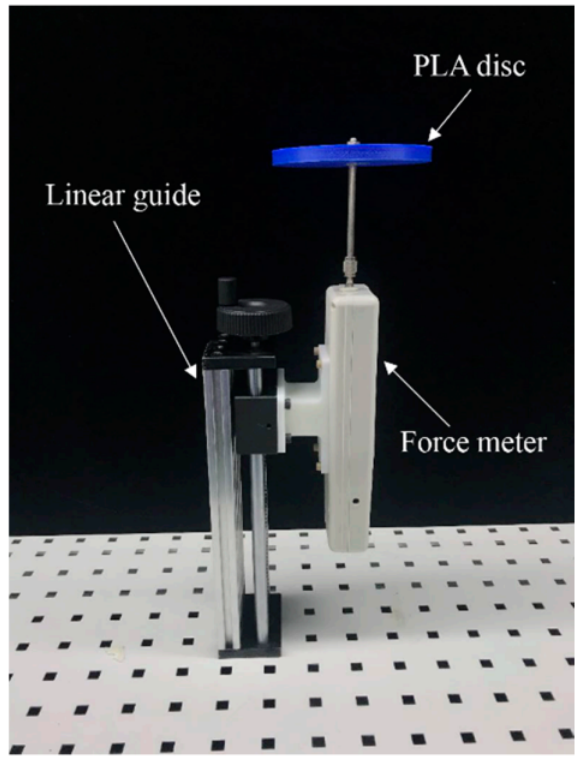
Figure 4. Setup of the grasp force